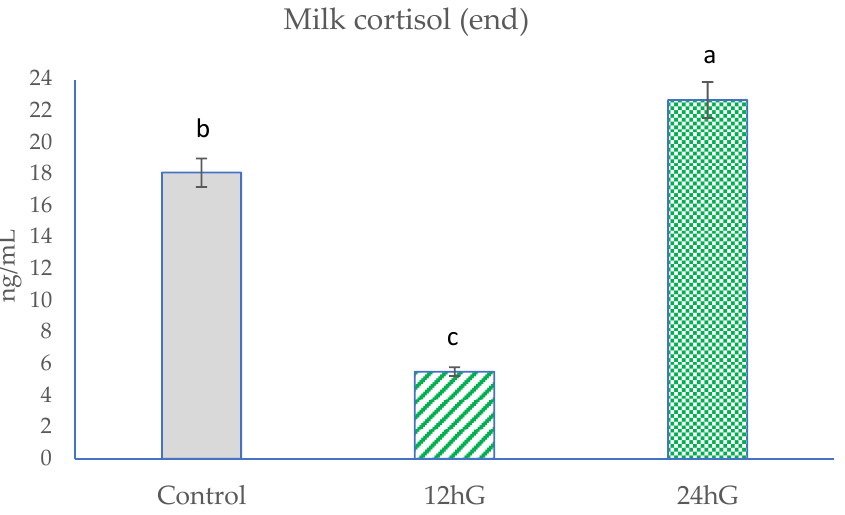
Figure 3. Milk cortisol levels at the end of the experiment in dairy cows. Control: non-grazing group; 12hG: 12 h grazing group; 24hG: 24 h grazing group. Columns represented by the different letters are significantly different at p < 0.05.